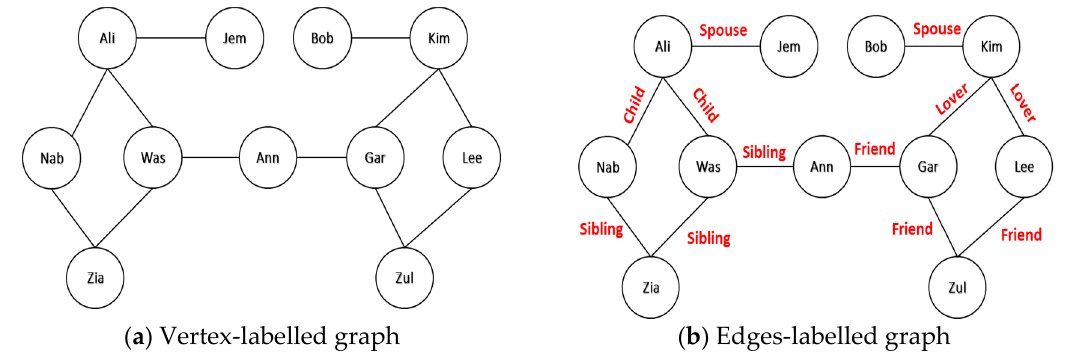
Figure 23. Example of the labelled-edges and -vertices graph of SN users.